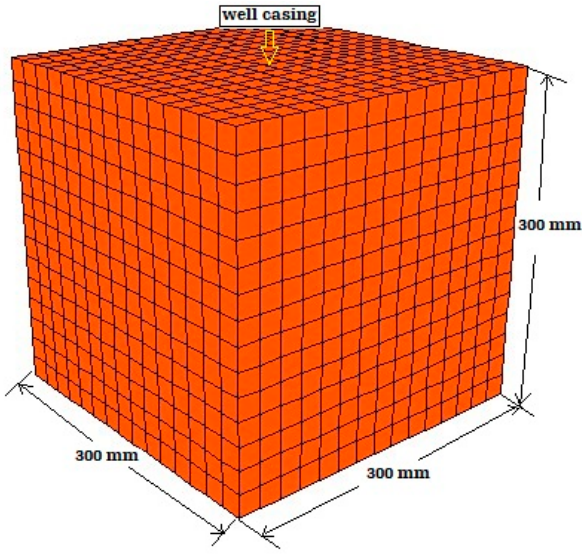
Figure 14. Schematic of the 3D geometry model. Table 3. Numerical simulation